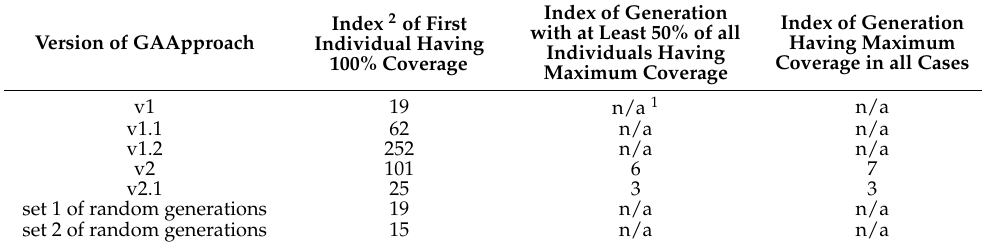
Table 2. Results for ALU when values of result were split in ten ranges.